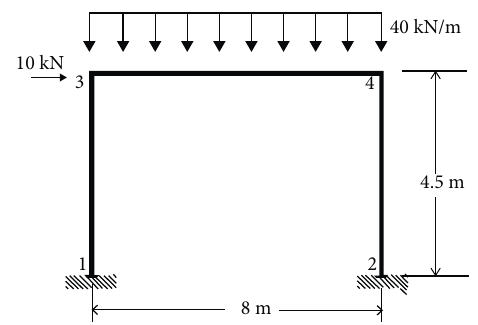
Figure 6: Gravity static loading for gravity analysis.